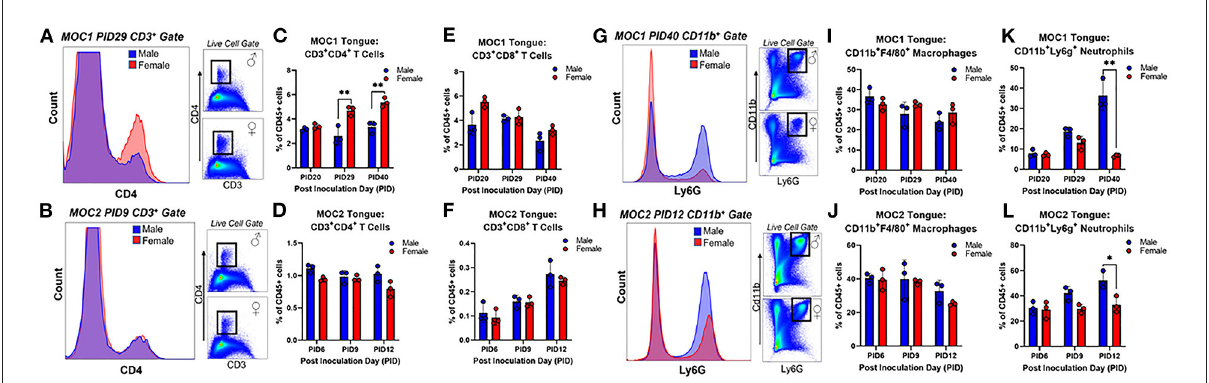
FIGURE6 Sex-specific changes in tongue tumor immune microenvironment. Representative histogram and scatter plots showing CD3 + CD4 + T cell populations in (A) tongue tissue from sham and MOC1 tumors at post inoculation day (PID) 29 and (B) tongue tissue from sham and MOC2 tumors at PID9. The percentage of CD45 + cells that were (C,D) CD3 + CD4 + T cells and (E,F) CD3 + CD8 + T cells were quantified in male and female tumor-bearing mice and compared across 3 timepoints (MOC1: PID20, 29 and 40; MOC2: PID6, 9, 12; n = 3/sex/timepoint). Representative histogram and scatter plots showing CD11b + Ly6G + neutrophil populations in (G) tongue tissue from sham and MOC1 tumors at PID40 and (H) tongue tissue from sham and MOC2 tumors at PID12. The percentage of CD45 + cells that were (I,J) CD11b + Ly6G + neutrophils and (K,L) CD11b + Ly6G − F4/80 + macrophages were quantified in male and female tumor-bearing mice and compared across 3 timepoints ( n = 3/sex/timepoint). Two-way ANOVA (sex by time), * p < 0.05, ** p <